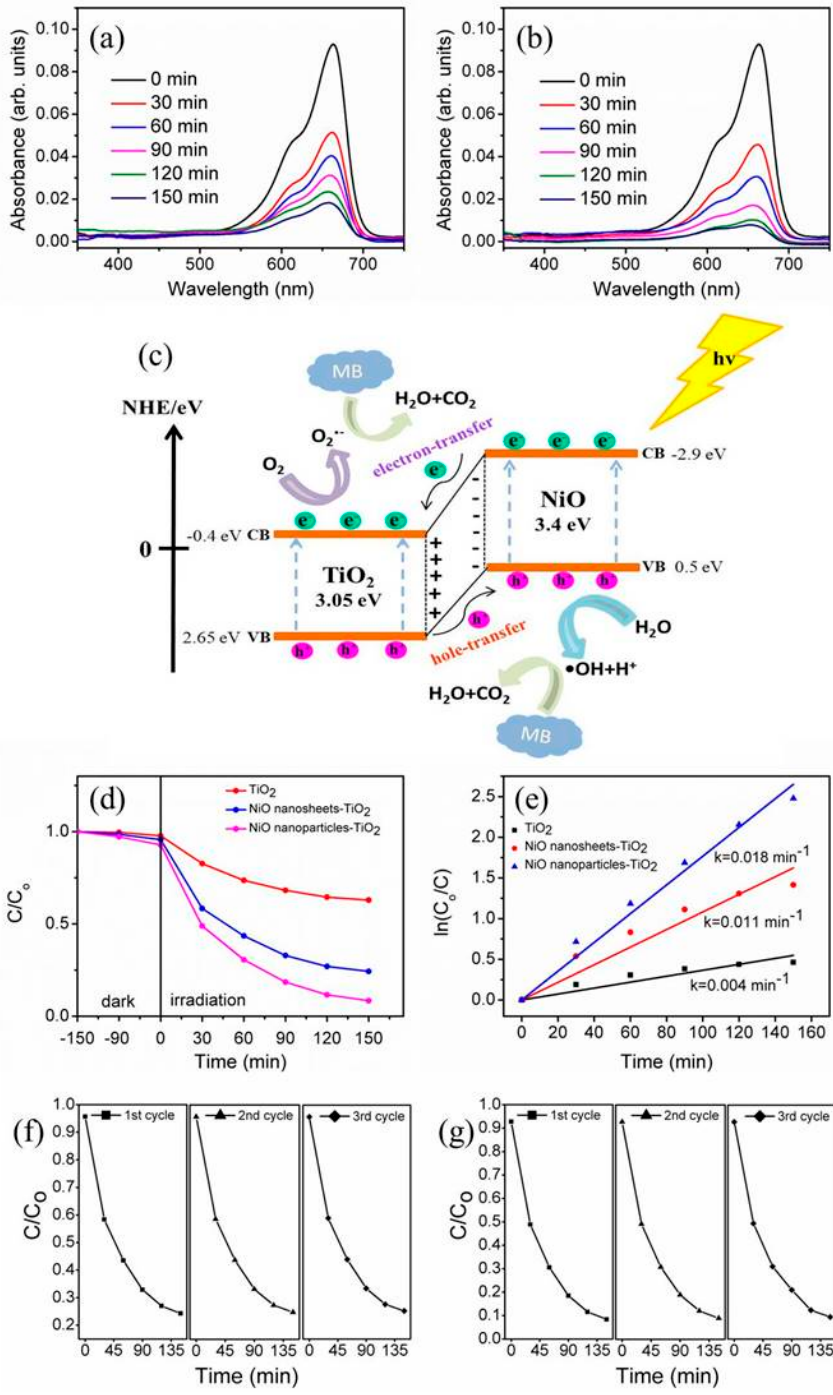
Figure 6. Intensity variation of absorbance spectra of the methylene blue (MB) solution vs. irradiation duration containing various TiO 2 –NiO composites under solar light irradiation: ( a ) NST. ( b ) NPT. ( c ) Schematic of photodegradation process of TiO 2 –NiO composites toward MB. ( d ) The ratio of the remaining MB concentration after light irradiation (C) and the initial MB concentration without light irradiation (C o ) vs. irradiation time curves for the MB solution containing various TiO 2 –NiO composites in dark conditions and under light irradiation. ( e ) Plot of ln (C o / C) vs. reaction time for MB solution containing various TiO 2 –NiO composites under irradiation. ( f , g ) Recycled performances of photodegradation of MB solution in the presence of the NST and NPT,